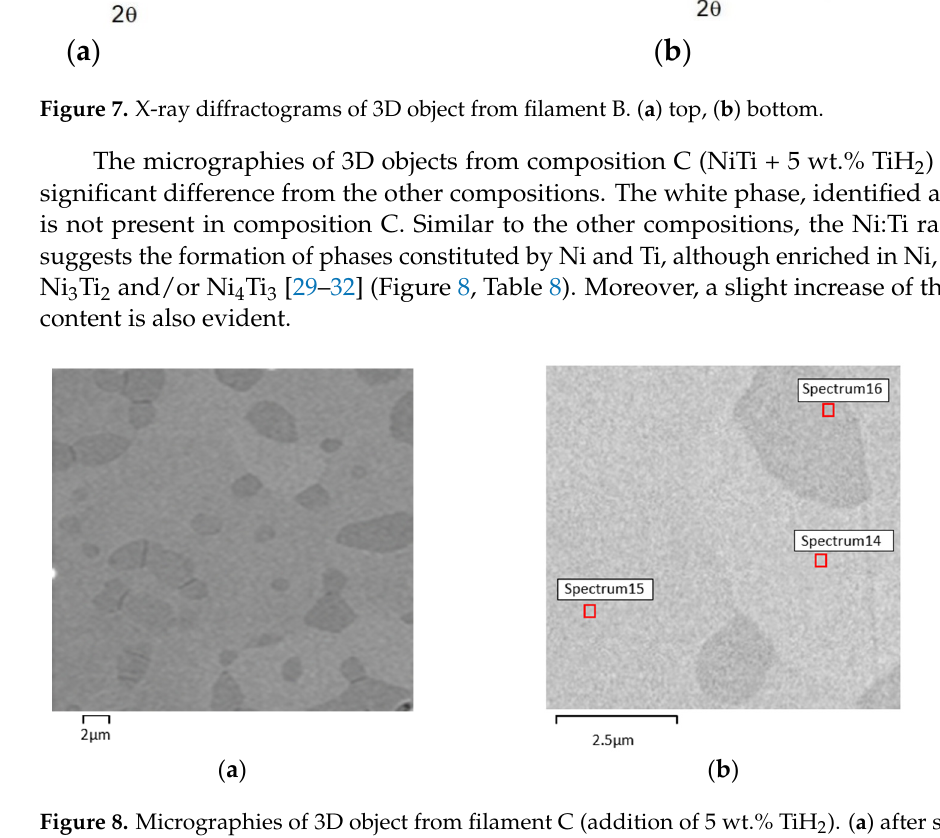
Figure 8. Micrographies of 3D object from filament C (addition of 5 wt.% TiH 2 ). ( a ) after sintering (SEM), ( b ) selected zones for evaluation of Ni:Ti ratio (S14, S15 and S16) by SEM/EDS. Table 8. Three-dimensional object phases from filament C after sintering (Spectra 14, 15, and 16 in Figure